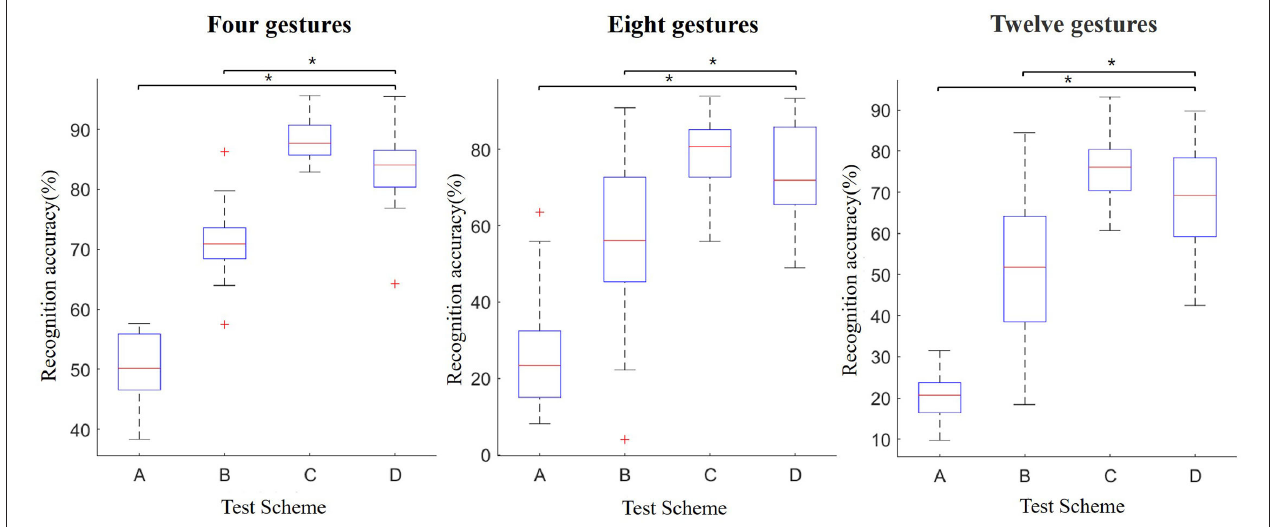
FIGURE 9 | Comparison of significance among different schemes (* p < 0.05).